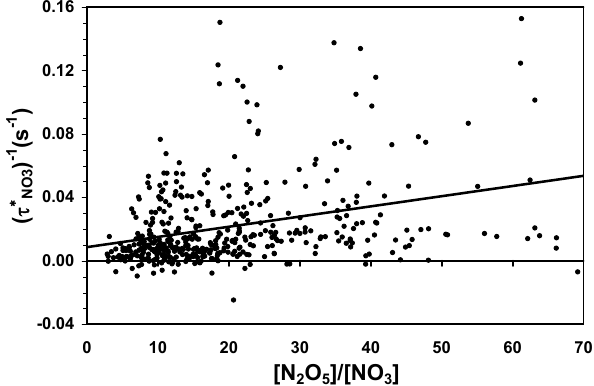
Fig. 8. Variation of inverse lifetime of NO 3 with N 2 O 5 /NO 3 ratio, including all 8 p.m.–8 a.m. data. Least squares analy- sis gives: intercept = k x = 0 . 0087 ± 0.0020sec − 1 ; slope = k y = 5 . 72 ( ± 0 . 81 ) × 10 − 4 s − 1 , as seen in Eq.